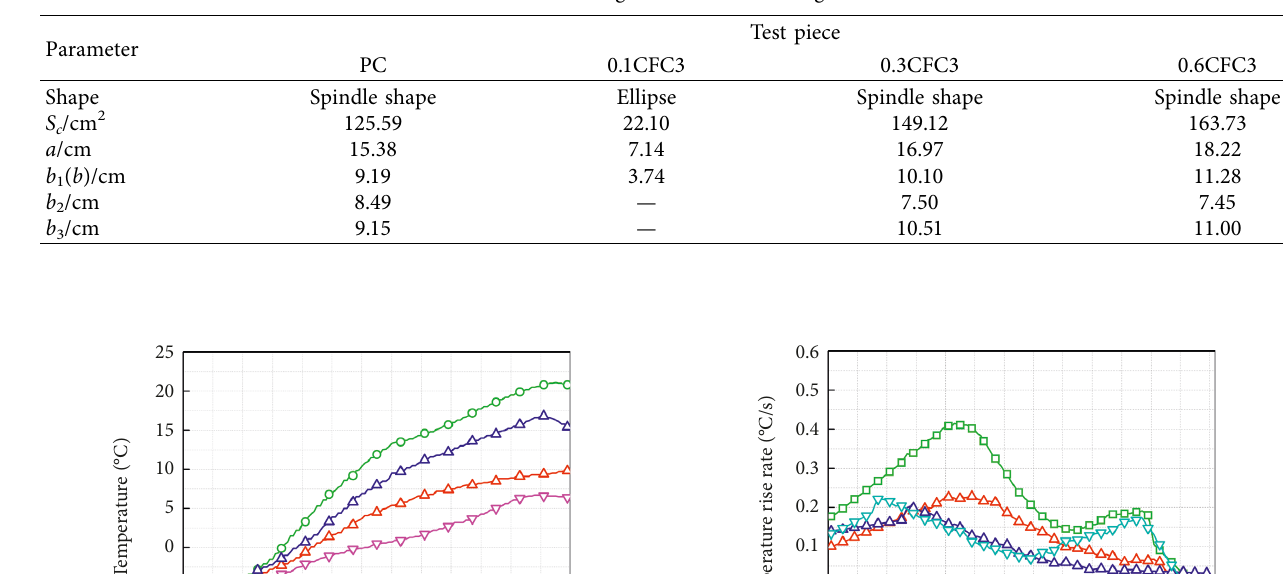
Table 4: Deicing area at different